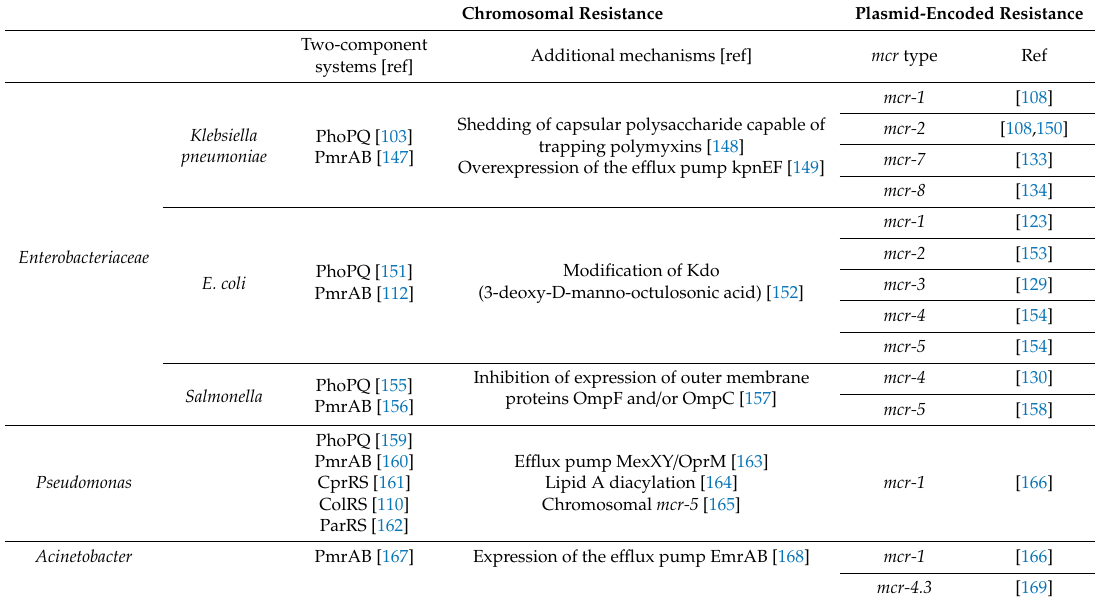
Table 3. Examples of chromosomal and plasmid-encoded polymyxin resistance mechanisms described in Enterobacteriaceae , Pseudomonas , and